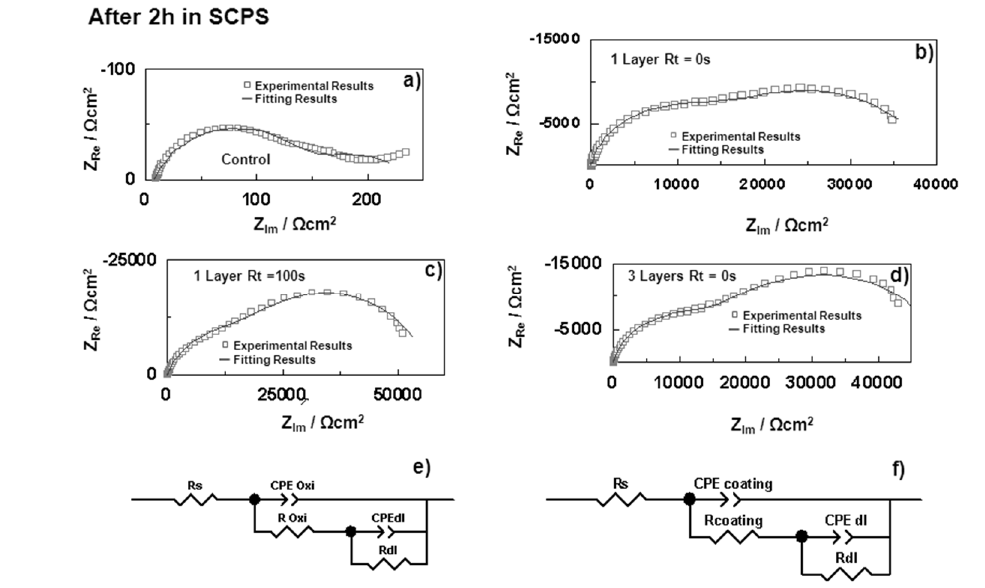
Figure 6. Nyquist plots for: ( a ) Control (uncoated HDGS) and HDGS samples coated with U(400) by one dip step; ( b ) Rt = 0 s and ( c ) Rt = 100 s; ( d ) HDGS samples coated by three consecutive dip steps and Rt = 0 s after 2 h of exposure to SCPS. EECs used for numerical fitting of the Nyquist plots for: ( e ) Control and ( f ) coated HDGS